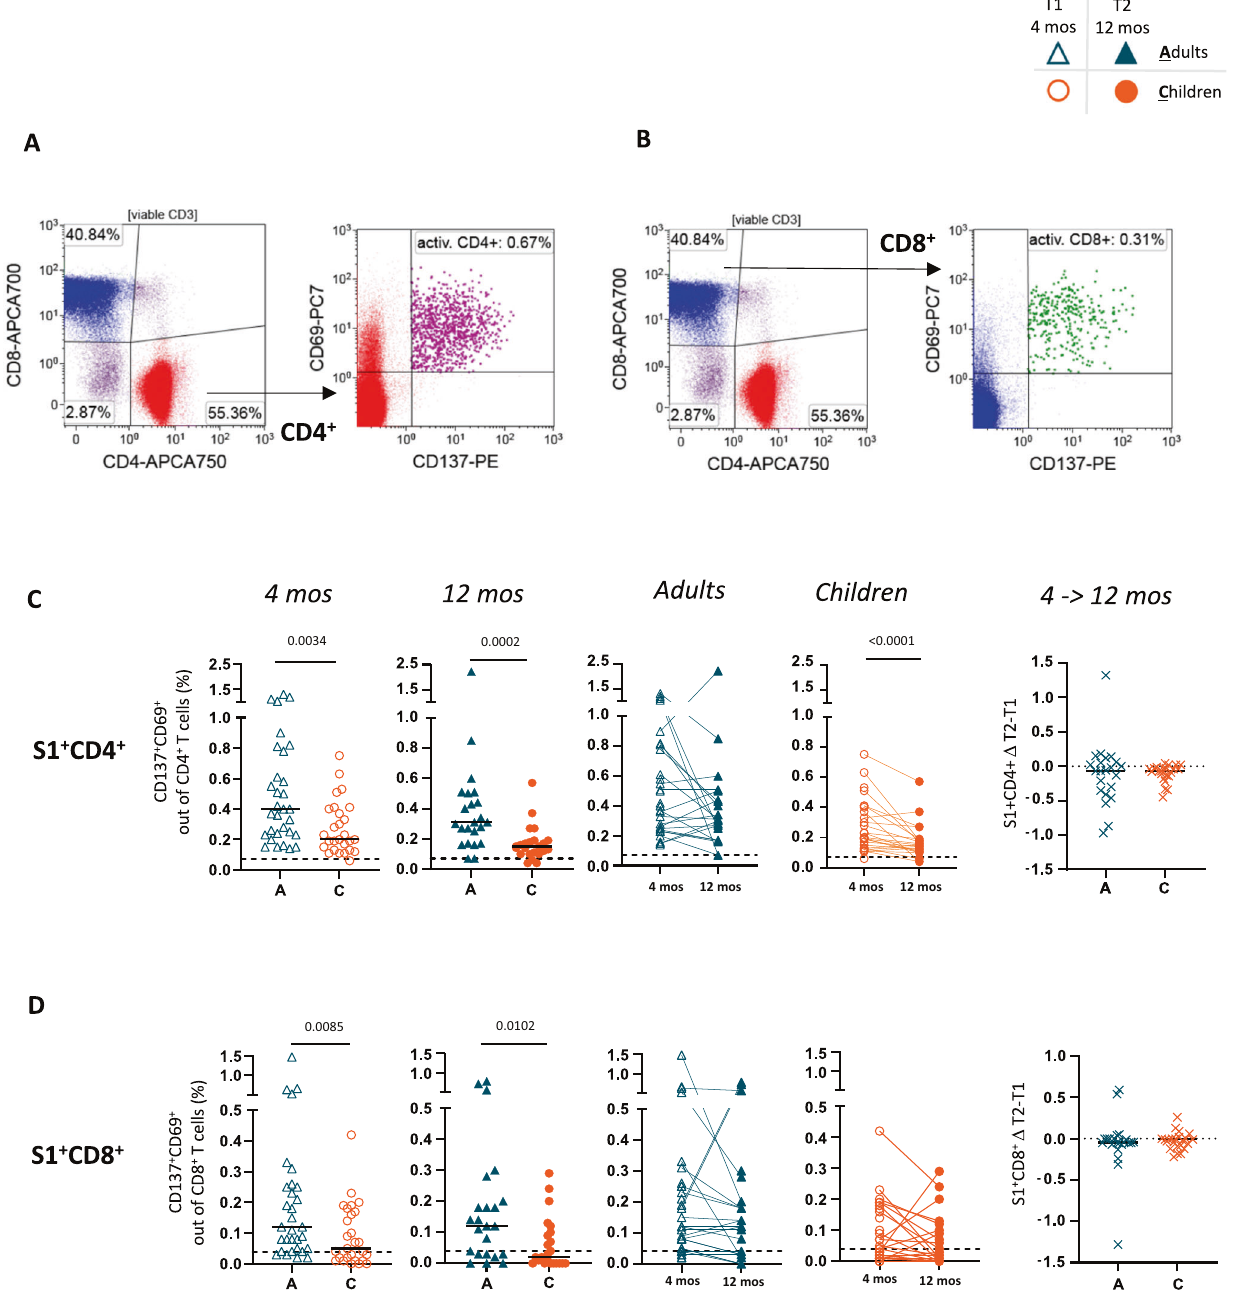
Fig. 4 | Low but stable S1 Speci fi c T cell response one year after SARS-CoV-2 infectioninchildren. The SARS-CoV-2-speci fi c T cellresponse was analyzedusing an activation-induced marker (AIM) assay by fl ow cytometric detection of CD69 + CD137 + T cells after stimulation with SARS-CoV-2 Spike 1 peptide mix. Representative dot plots of CD69 + CD137 + CD4 + ( A ) and CD8 + ( B ) T cells are shown. The results for CD4 + ( C ) and CD8 + ( D ) of seropositive adults (blue) and children (orange)at4months(opensymbols)and12months( fi lledsymbols)afterinfection